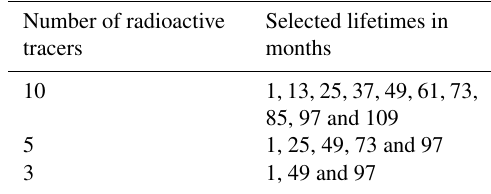
Table 2. Radioactive trace gas